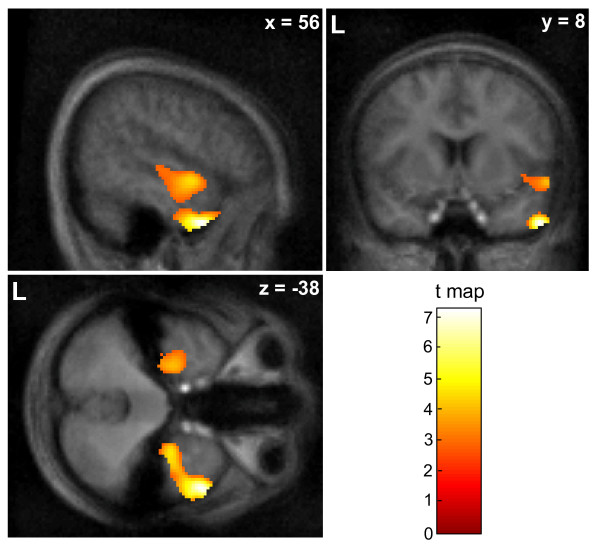
Statistical maps on the behavioral prediction of lower individual responsiveness to failure events (cluster-size corrected p < 0.05). A negative association between failure response and negative affect were observed at the right temporal pole; other clusters comprised periaqueductal gray as well as orbitofrontal and premotor cortices (Table 3). No area predicted positive affect or higher negative affect.